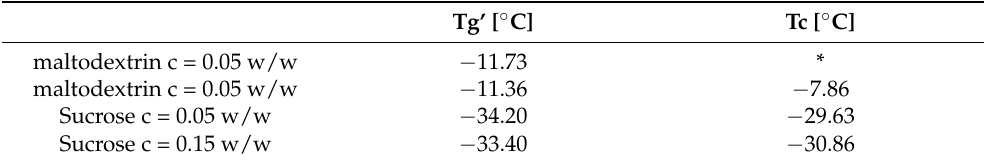
Table 2. Overview of Tc and Tg’ for maltodextrin and sucrose solutions with different solid concentrations. Tg’ [ ◦ C] Tc [ ◦ C] maltodextrin c = 0.05 w/w maltodextrin c = 0.05